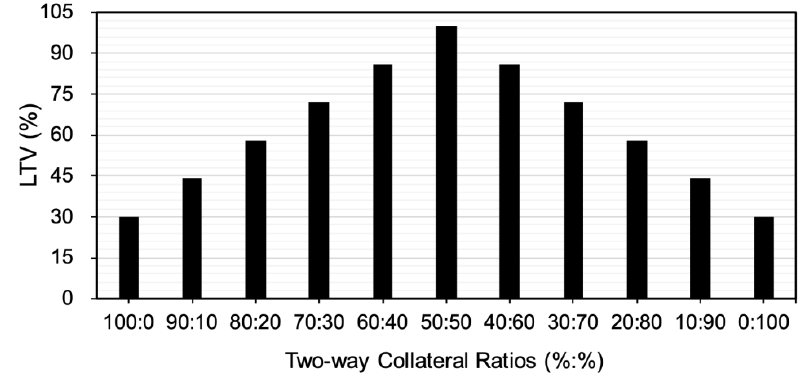
Fig. 4 LTV ratios by two-way collateral ratios in Table